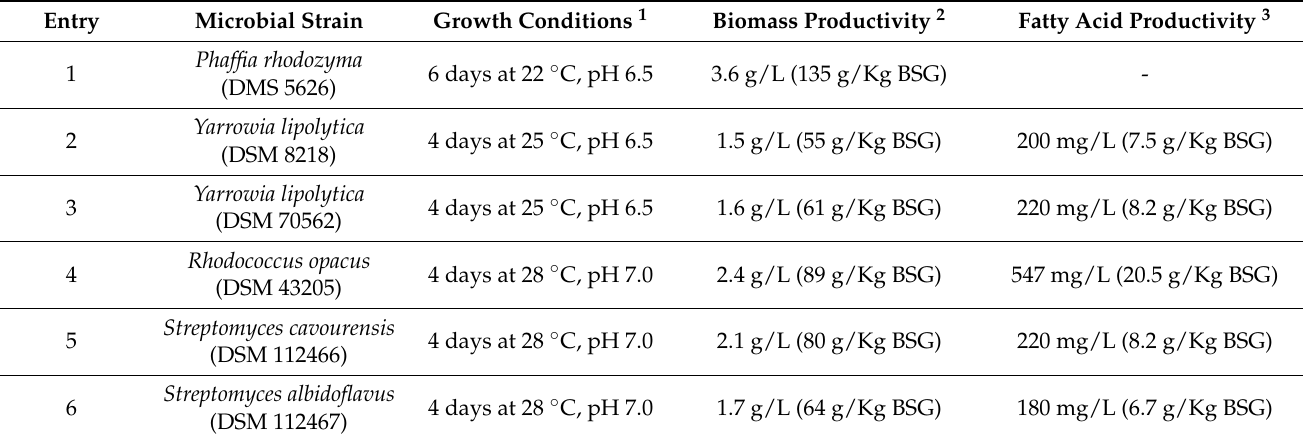
Table 1. Production of biomass and fatty acids using the BSG medium and some selected microbial